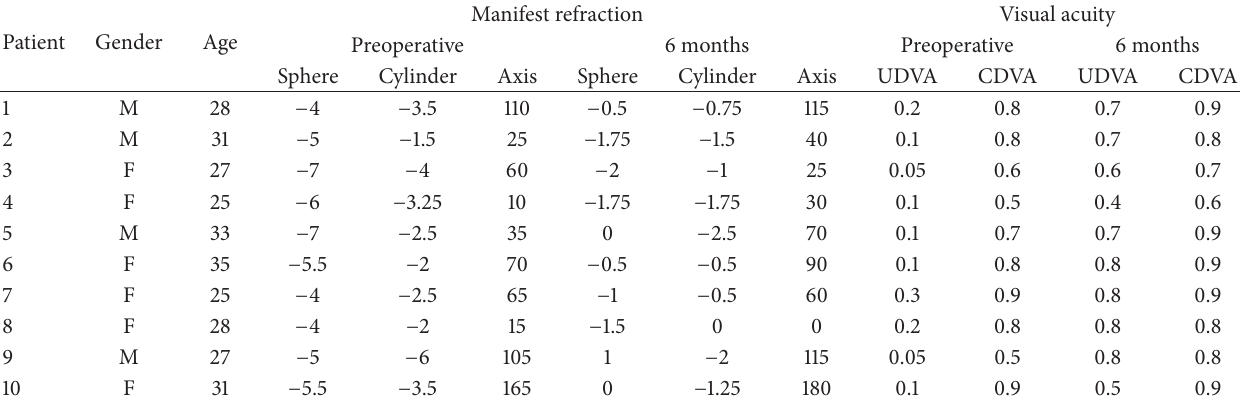
Table 1: Demographic, refractive, and visual data of postkeratoplasty smile